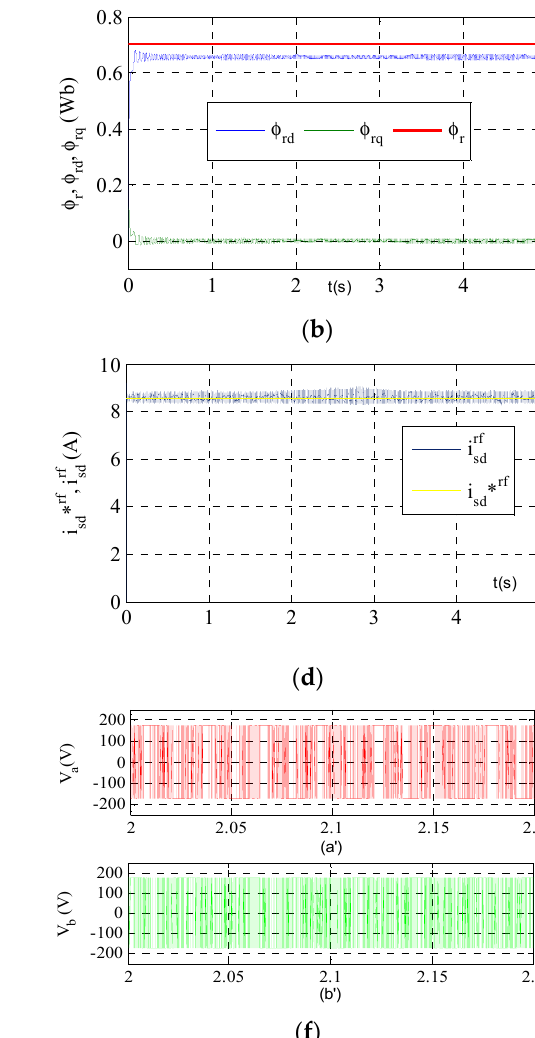
Figure 11. Simulation results of IRFOC no-loaded TPIM drive fed by an advanced SVM controlled 2 ϕ -inverter under linear constant wind speed profile: ( a ) turbine and TPIM speeds; ( b ) rotor fluxes; ( c ) reference and TPIM electromagnetic torques; ( d ) d-axis reference and actual stator currents and ( e ) q-axis reference and actual stator currents.